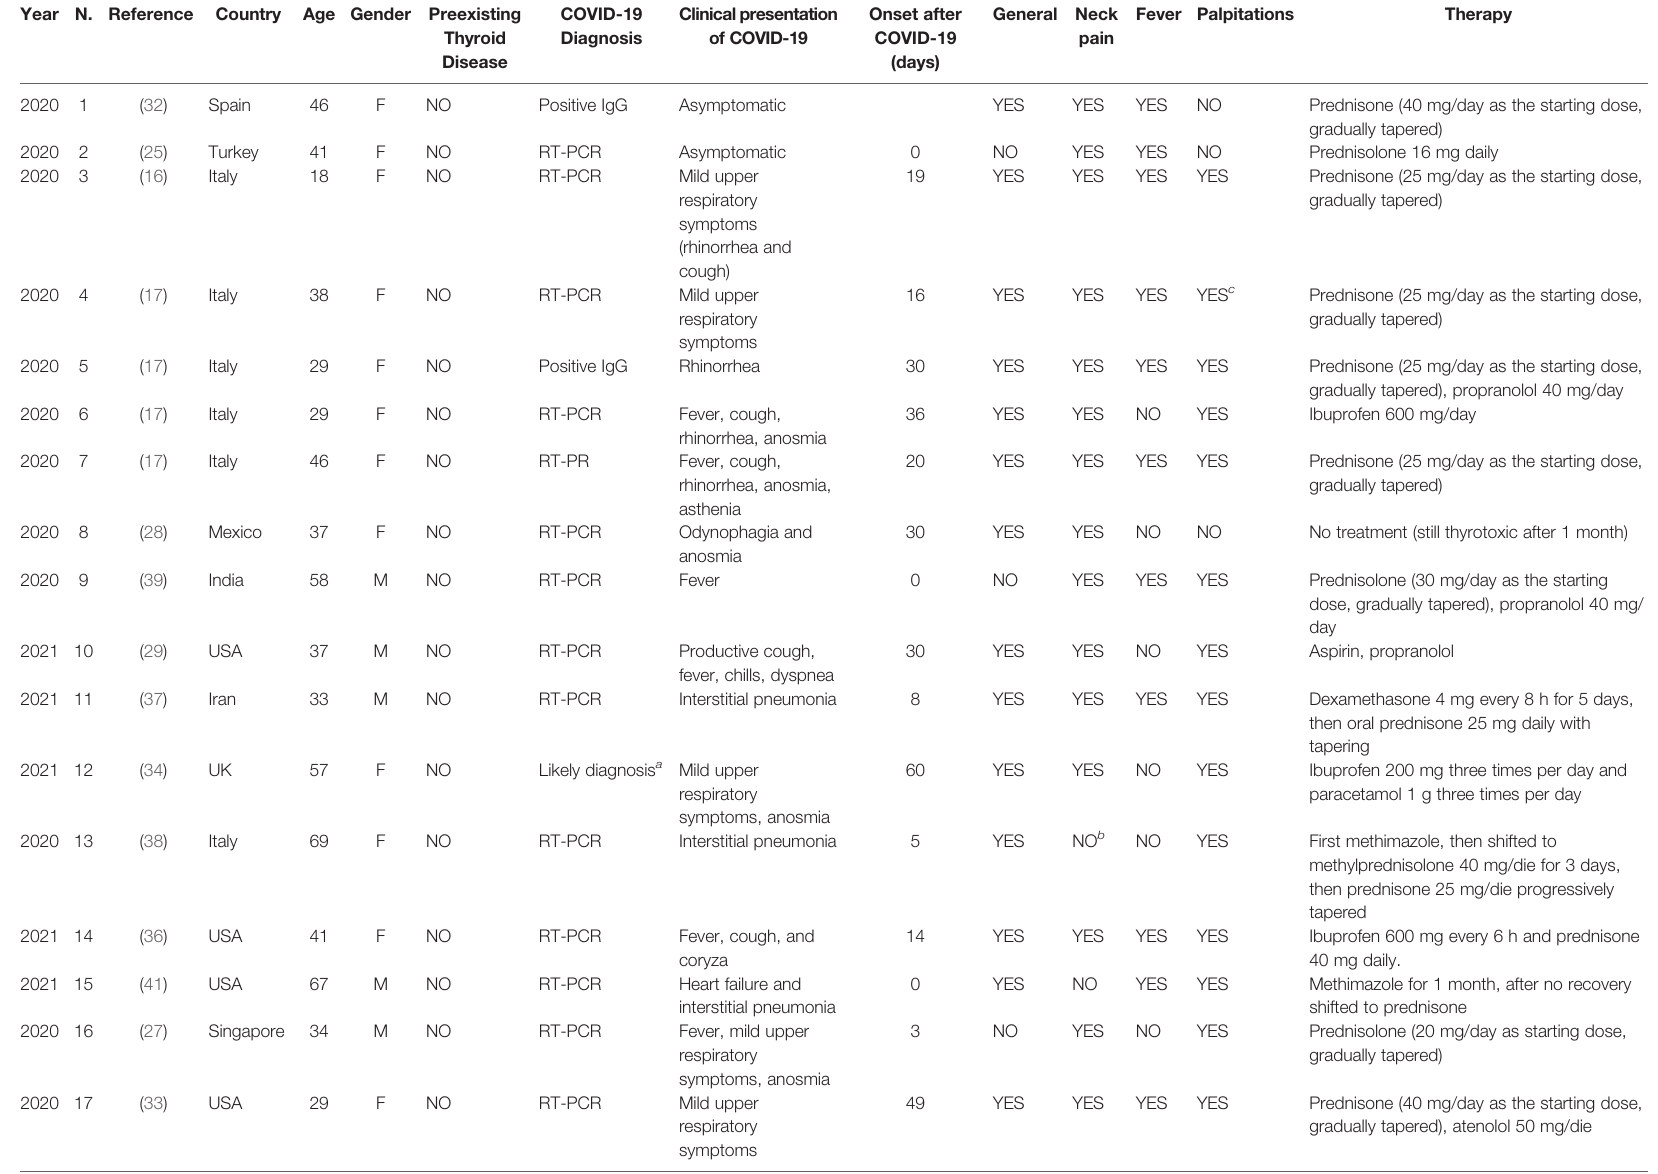
TABLE 1 | Description of the anagraphic characteristics and clinical presentation of COVID-19 and SAT of the 27 included patients. Year N. Reference Country Age Gender Preexisting